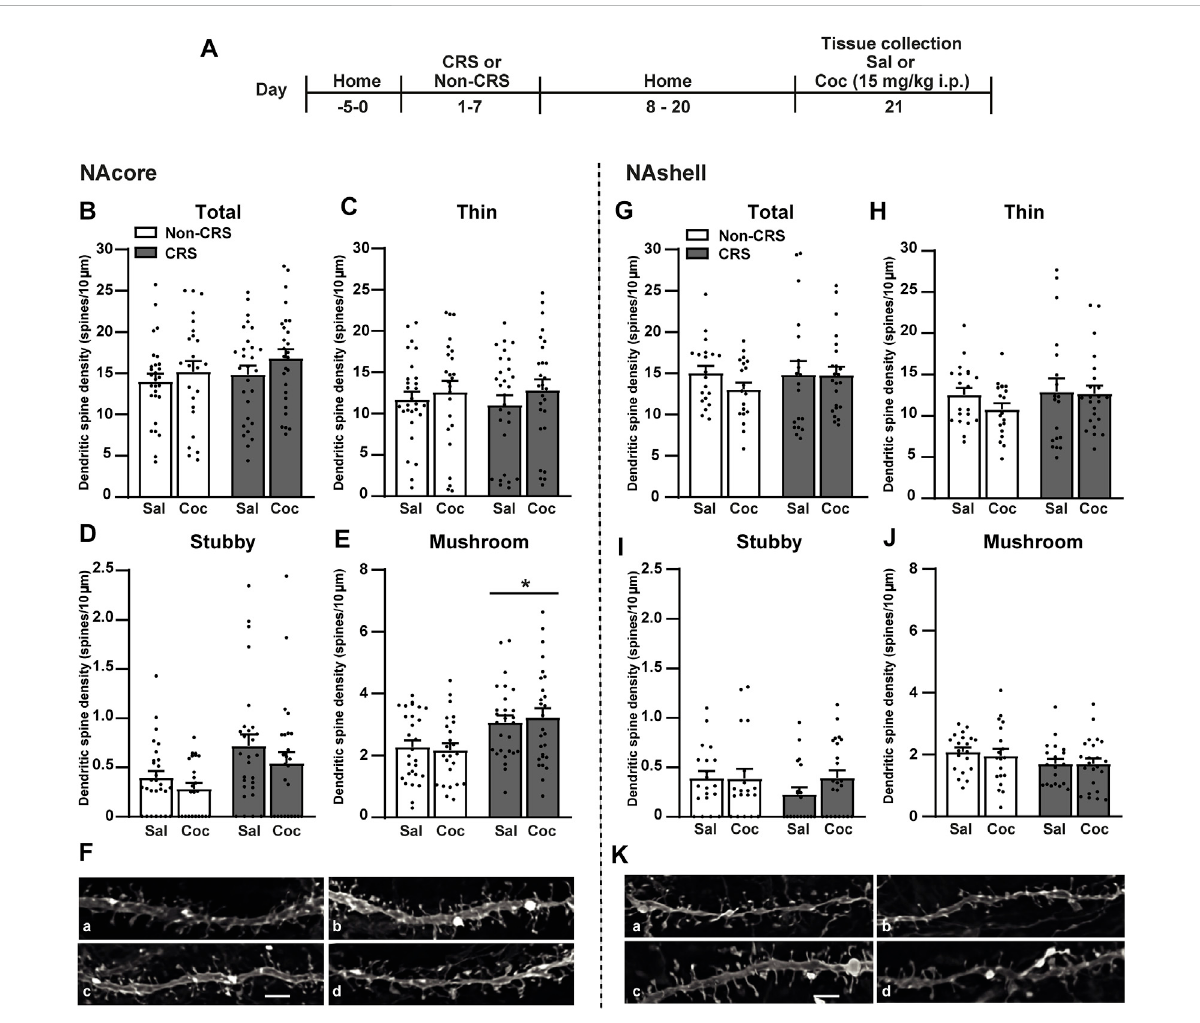
FIGURE 3 Chronicstressexposureinducedanincreaseinthedensityofmushroom-shapeddendriticspinesexclusivelyintheNAcore. (A) Schematictimelineofthe experimentalprotocol. (B – E) Total,thin,stubbyandmushroom-shapeddendriticspinedensityexpressedper10 µmofNAcoreMSNdendritesegment.Threeto sevensegmentswereanalyzedperanimal.Totaldataanalyzed:Non-CRS/Sal(28segments;1,027 µmdendriticlength,sevenrats),Non-CRS/Coc(24segments; 882 µmdendriticlength,sixrats),CRS/Sal(28segments;1,037 µmdendriticlength,sixrats)andCRS/Coc(27segments;823 µmdendriticlength,sixrats). Totalandthinspinedensity:Two-waynesteddesignANOVArevealednoeffectofstressordrugeitherfortotal(Non-CRSvs.CRS;F (1,22) =0.62,n.s. – Salvs.Coc; F (1,22) =0.30,n.s.)orthinspinedensities(Non-CRSvs.CRS;F (1,22) =0.02,n.s. – Salvs.Coc;F (1,22) =0.09,n.s.).Althoughtwo-waynesteddesignANOVArevealed interactionfortotal(Non-CRSvs.CRSxSalvs.Coc;F (1,22) =255.23, p < 0.0001)andthinspinedensities(Non-CRSvs.CRSxSalvs.Coc;F (1,22) =118.34, p < 0.0001), one-way ANOVA to test signi fi cant variations in means among groups showed no statistical differences among them either for total (F (3,103) = 1.12, n.s.) or thin spinedensities(F (3,103) =0.49,n.s.).Stubbyspinedensity:Two-waynesteddesignANOVArevealednoeffectofstress(Non-CRSvs.CRS;F (1,22) =4.06,n.s.)ordrug (Salvs.Coc;F (1,22) =0.77,n.s.),butsigni fi cantinteraction(Non-CRSvs.CRSxSalvs.Coc;F (1,22) =61.63, p < 0.0001).Althoughone-wayANOVAshowedsigni fi cant variationsinmeansamonggroupsforstubbyspinedensity(F (3,103) =3.84, p < 0.05),Bonferroni post-hoc testrevealednosigni fi canteffectofstressand/ordrug (n.s.).Mushroom-shapedspinedensity:Two-waynesteddesignANOVArevealedinteraction(Non-CRSvs.CRSxSalvs.Coc;F (1,22) =230.18, p < 0.0001)anda main signi fi cant effect of stress (Non-CRS vs. CRS; F (1,22) = 5.33, p < 0.05) but non-signi fi cant effect of drug (Sal vs. Coc; F (1,22) = 0.24, n.s.). Although one-way ANOVAshowedsigni fi cantvariationsinmeansamonggroupsformushroom-shapedspinedensity(F (3,103) =4.91, p < 0.01),Bonferroni post-hoc testrevealedno signi fi canteffectofstressand/ordrug(n.s.). (F) RepresentativelabelingofdendriticshaftandspineimagesofMSNsintheNAcore:Non-CRS/Sal (a) ,Non-CRS/ Coc (b) , CRS/Sal (c) , CRS/Coc (d) . (G – J) Total, thin, stubby and mushroom-shaped dendritic spine density expressed per 10 µm of NAshell MSN dendrite segment.Twotosevensegmentswereanalyzedperanimal.Totaldataanalyzed:Non-CRS/Sal(20segments;835 µmdendriticlength, fi verats),Non-CRS/Coc (19segments;711 µmdendriticlength, fi verats),CRS/Sal(19segments;805 µmdendriticlength, fi verats)andCRS/Coc(23segments;817 µmdendriticlength, sixrats).Two-waynesteddesignANOVArevealednoeffectofstressordrugeitherfortotal(Non-CRSvs.CRS;F (1,18) =0.02,n.s. – Salvs.Coc;F (1,18) =0.34,n.s.), thin(Non-CRSvs.CRS;F (1,18) =0.13,n.s. – Salvs.Coc;F (1,18) =0.44,n.s.),stubby(Non-CRSvs.CRS;F (1,18) =1.14,n.s. – Salvs.Coc;F (1,18) =1.69,n.s.)ormushroom- shapedspinedensities (Non-CRS vs. CRS;F (1,18) = 2.513, n.s. – Sal vs. Coc; F (1,18) = 0.001, n.s.). Althoughtwo-way nested designANOVA revealedinteractionfor total(Non-CRSvs.CRSxSalvs.Coc;F (1,18) =212.58, p < 0.0001),thin(Non-CRSvs.CRSxSalvs.Coc;F (1,18) =172.85, p < 0.0001),stubby(Non-CRSvs.CRSxSalvs. Coc; F (1,18) = 75.87, p < 0.0001) and mushroom-shaped spine densities (Non-CRS vs. CRS x Sal vs. Coc; F (1,18) = 282.73, p < 0.0001), no signi fi cant variations in means among groups were found with one-way ANOVA for total (F (3,77) = 0.64, n.s.), thin (F (3,77) = 0.78, n.s.), stubby (F (3,77) = 1.00, n.s.) and mushroom-shaped spinedensities(F (3,77) =1.20,n.s.). (K) RepresentativelabelingofdendriticshaftandspineimagesofMSNsintheNAshell:Non-CRS/Sal (a) ,Non-CRS/Coc (b) ,CRS/ Sal (c) , CRS/Coc (d) . All data are shown as mean ± SEM. Scale bar: 3 μ m. (CRS, chronic restraint stress; Sal, saline; Coc,